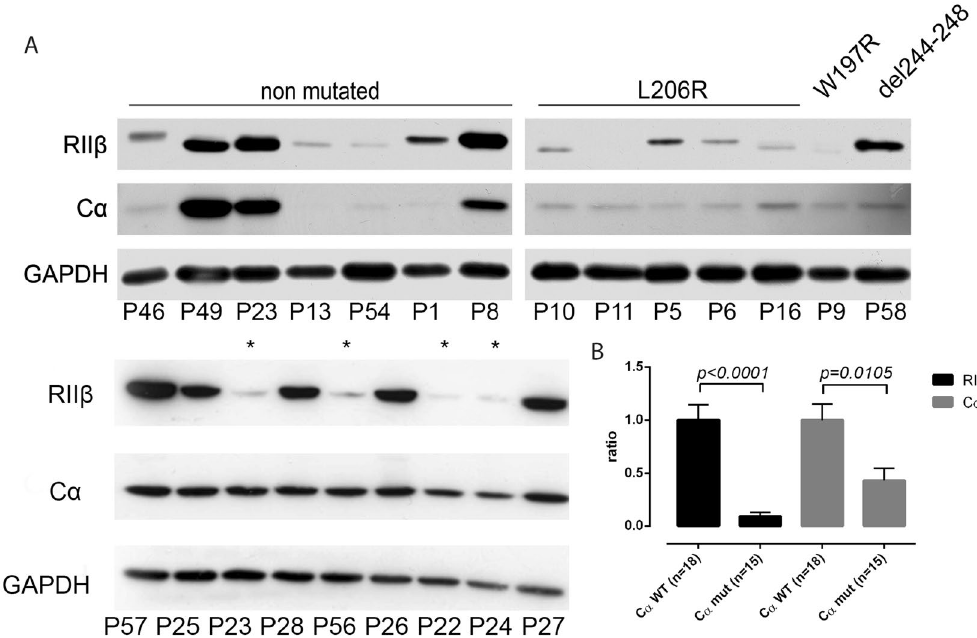
Figure 2. Western blots of cortisol producing adrenocortical adenomas. Western blotting of RII β , C α and GAPDH. The patient ID according to Supplementary Tables S1a and b are given under each band. PRKACA mutation status is indicated as such and “ * ” indicates samples harbouring the L206R mutation in PRKACA , as well ( A ). Densiometric analysis of western blots was done using the Fiji software 32 . The quotient of RII β / GAPDH and C α /GAPDH was normalized to the mean of WT RII β GAPDH or C α /GAPDH and this ratio is shown on the y-axis ( B